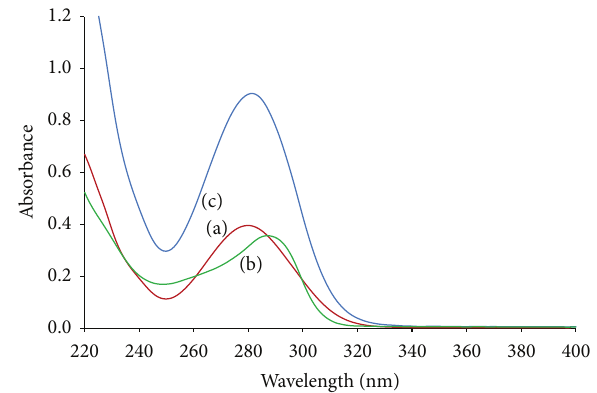
Figure 2: Overlay zero-order spectra of (a) diclofenac, (b) panto- prazole, and (c) pharmaceutical tablet